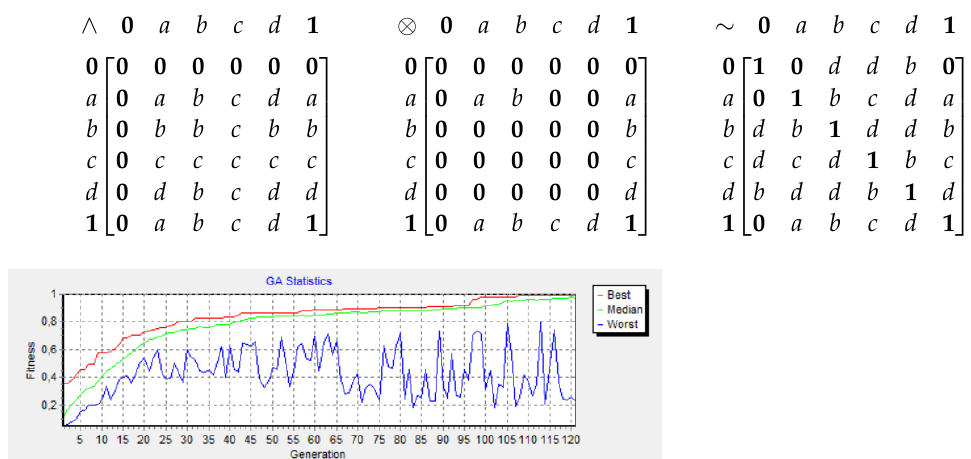
Figure 18. EQCreator computation for special